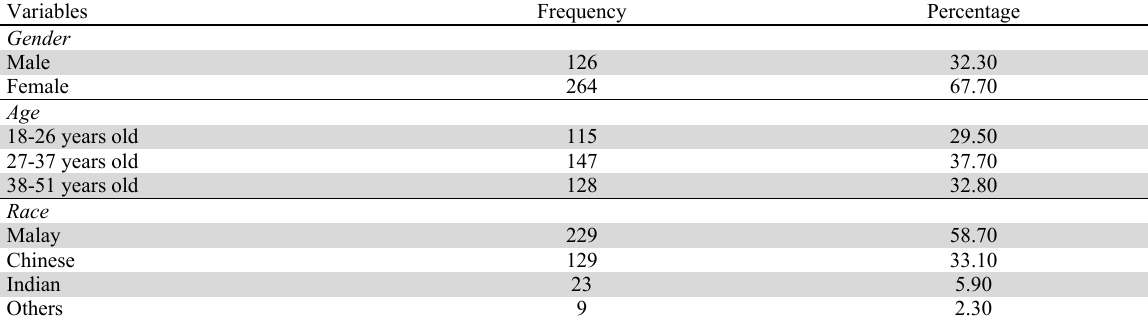
Background of Respondents